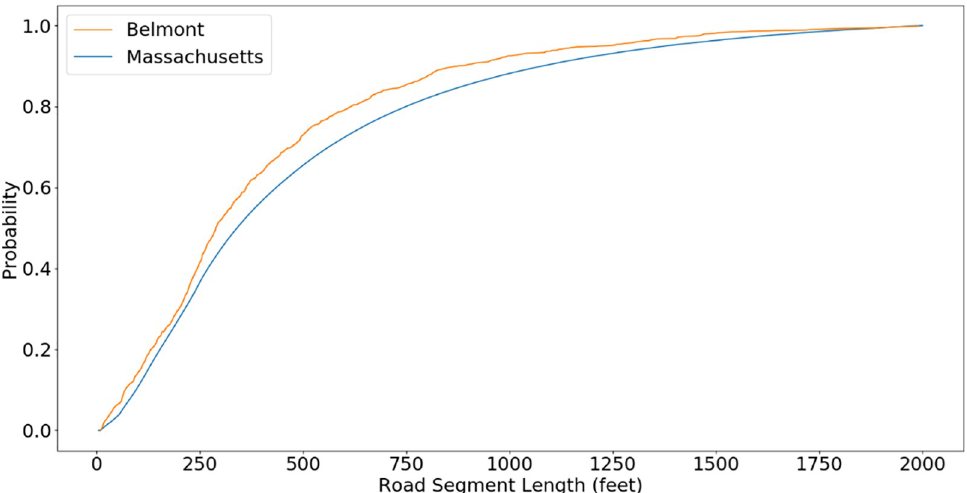
Fig 3. CDF for lengths of street segments for the Town of Belmont, Massachusetts (orange) and for all the communities of the Commonwealth of Massachusetts (blue).